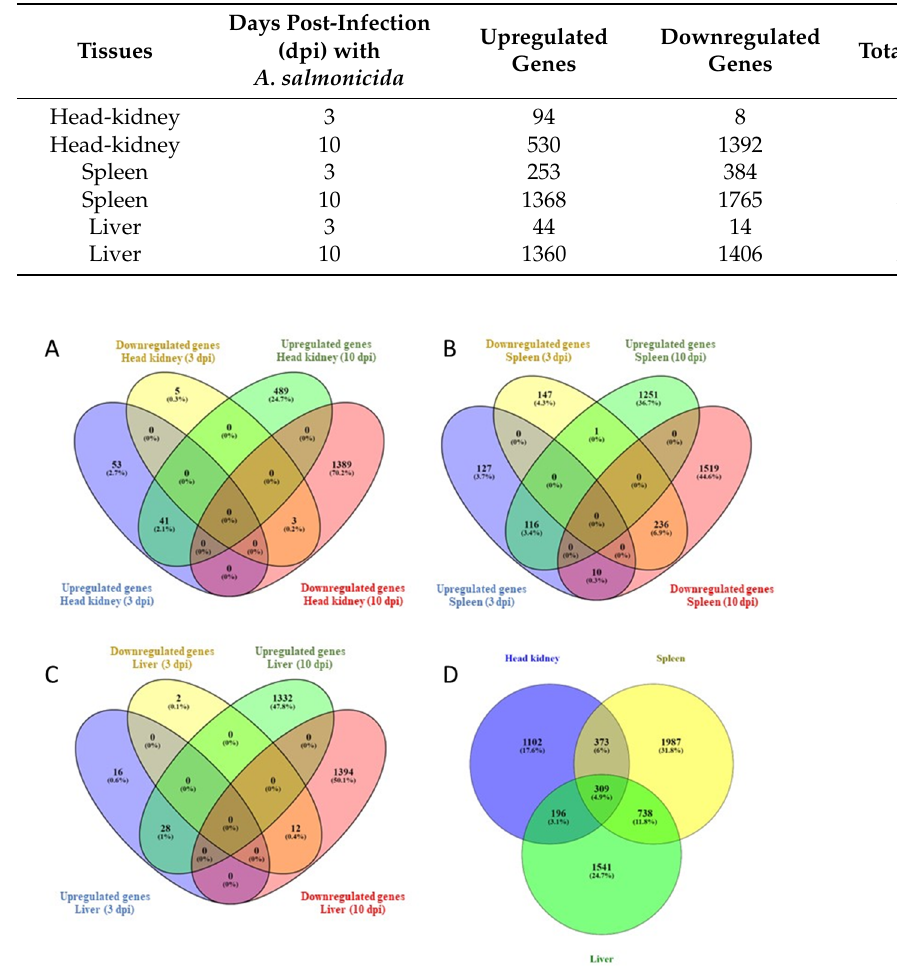
Table 1. Differentially expressed Genes (DEGs) identified by reference transcriptome analysis.